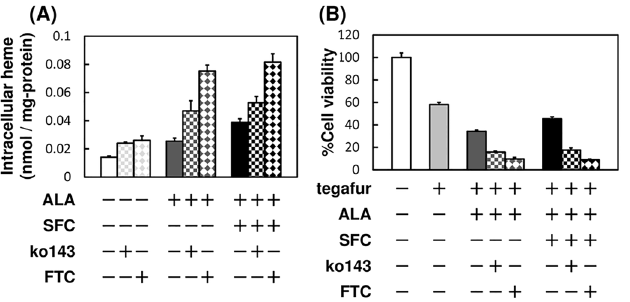
Fig 4. The effect of inhibitors of ABCG2 transporter activity on tegafur activation. (A) The effect of ABCG2 inhibitor on heme synthesis in the presence of ALA alone or together with SFC. Cells were incubated in culture medium containing inhibitors (5 μ M Ko143, 10 μ M FTC, or 100 μ M cholic acid), 1.0 mM ALA, and 0.5 mM SFC for 8 h and were subsequently analyzed for heme content. (B) The effect of ABCG2 inhibitor on the cytotoxic effect of tegafur in the presence of ALA alone or together with SFC. Cells were incubated in culture medium containing inhibitors (5 μ M Ko143 or 10 μ M FTC), 1.0 mM tegafur, 0.3 mM NADPH, 1.0 mM ALA, and 0.5 mM SFC for 96 h and were subsequently analyzed for viability. Data are expressed as means ± S.D. in three (A) or four (B) independent experiments.